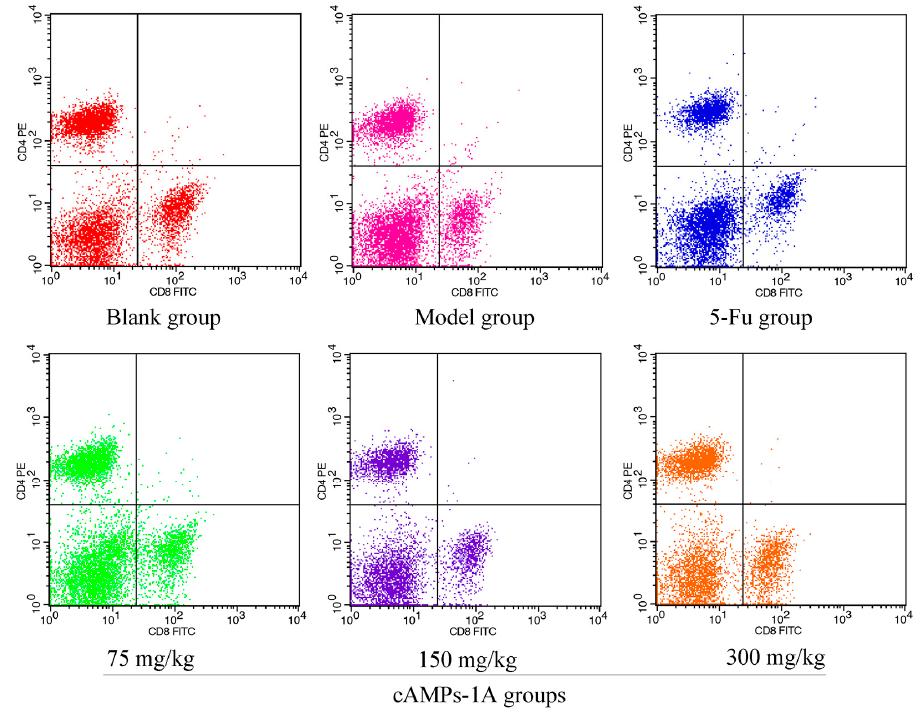
Figure 5. Effects of cAMPs-1A on T cells subsets distribution in peripheral blood of H22-bearing mice.